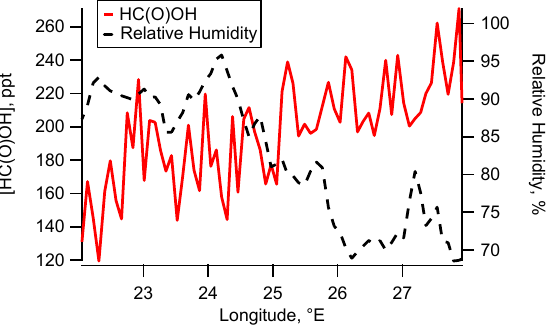
Figure 6. The change in HC(O)OH concentration and relative humidity in relation to longitude, ° E along transect x during flight B796b on 16 August 2013.